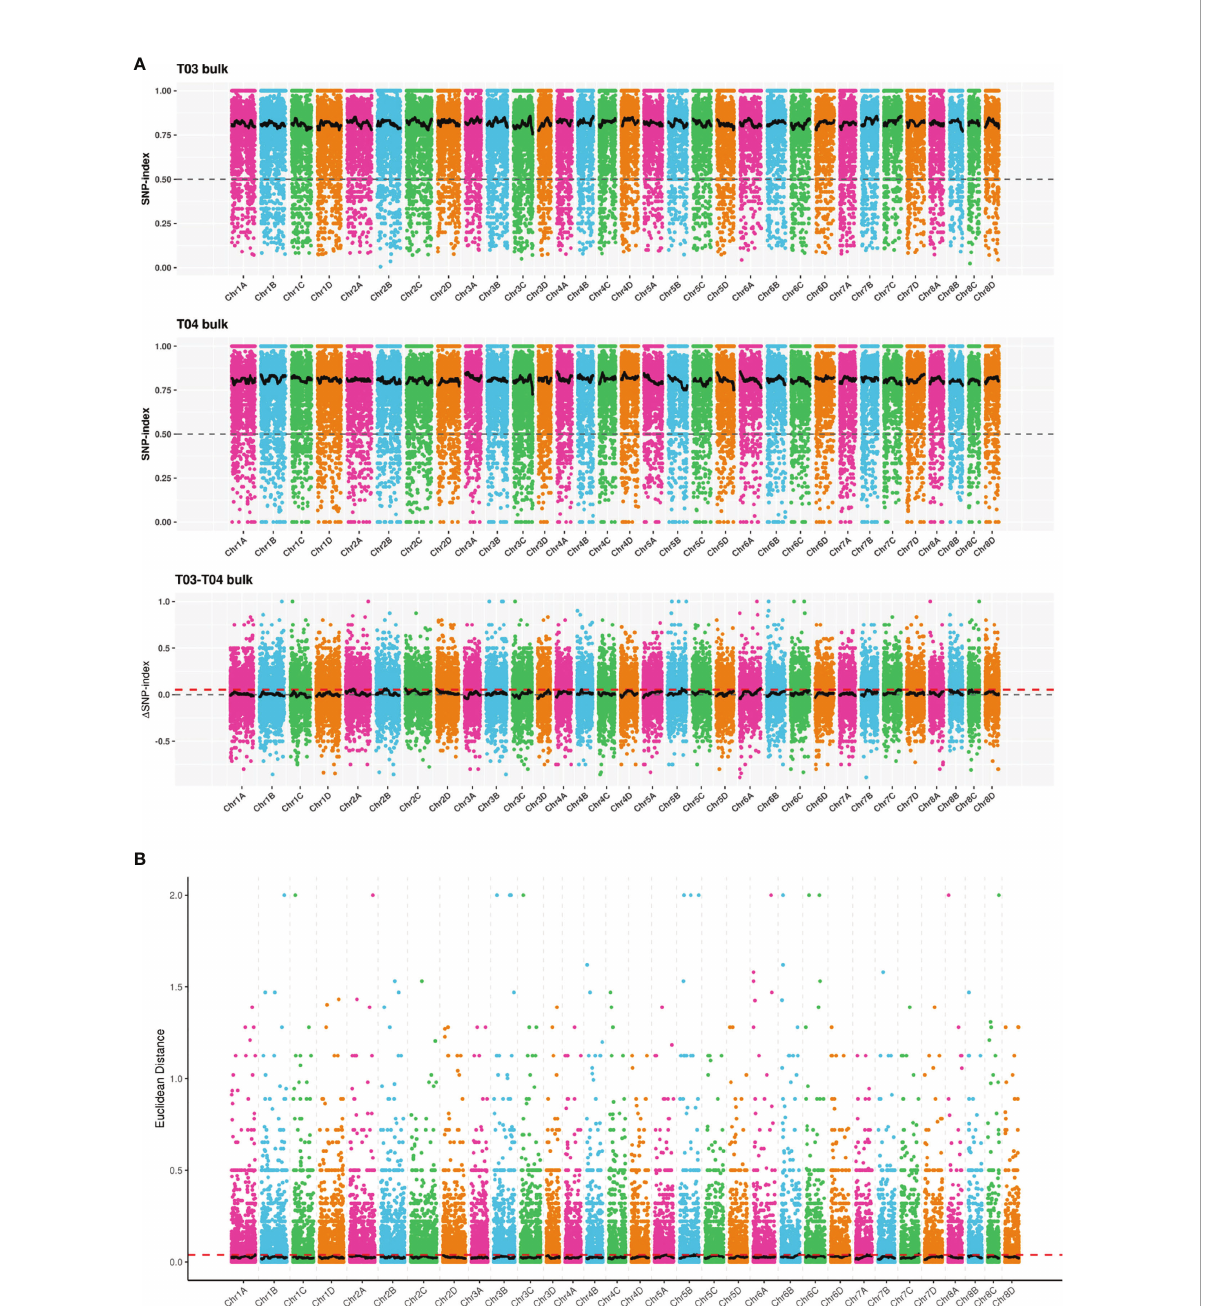
FIGURE 6 Distribution of correlation values for D SNP-index (A) and Euclidean distance (ED) (B) methods on the S. spontaneum chromosomes. The colored dots represent the D SNP-index or ED value, the black line represents the fi tted D SNP-index or ED value, and the red dotted line represents the signi fi cance